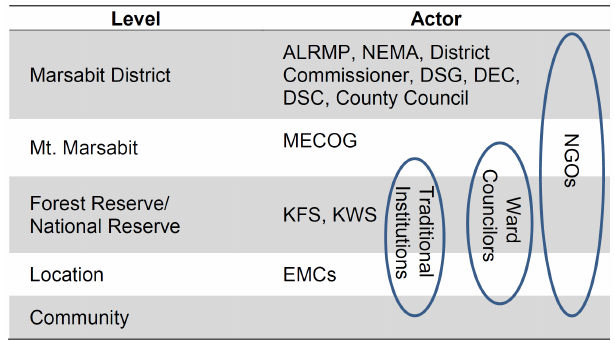
Fig. 1 . Key actors and the level at which they operate. (ALRMP = Arid Lands Resource Management Project; NEMA = National Environment Management Authority; DSG = District Steering Group; DEC = District Environment Committee; MECOG = Marsabit Environmental Conservation Group; KFS = Kenya Forest Service; KWS = Kenya Wildlife Service; EMCs = environmental management